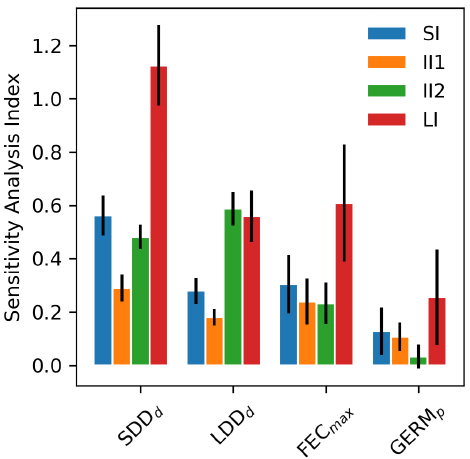
Figure 1. Mean sensitivity analysis (SA) indices ( ± 2 standard er- rors) across 17 tree species for the four parameters of the newly im- plemented migration module of LPJ-GM: average short dispersal distance (SDD d , m), 1% average long dispersal distance (LDD d , metres), maximum fecundity per tree (FEC max , no. of seeds per 100yr), and seed germination rate (GERM p , %). See Sect. 2.5.1 for the calculation of SA indices: sensitivity index (SI), importance indexes (II1 and II2), and linearity index (LI). See Table S1 for species-specific